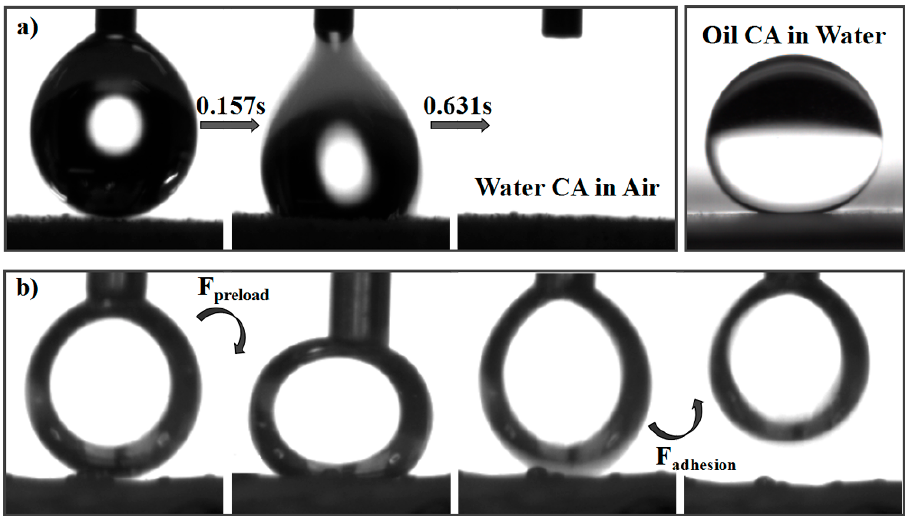
Figure 4. ( a ) Wettability of the CSPNM toward ( left ) water in air and ( right ) oil under water; ( b ) photographs of underwater oil contact the CSPNM.